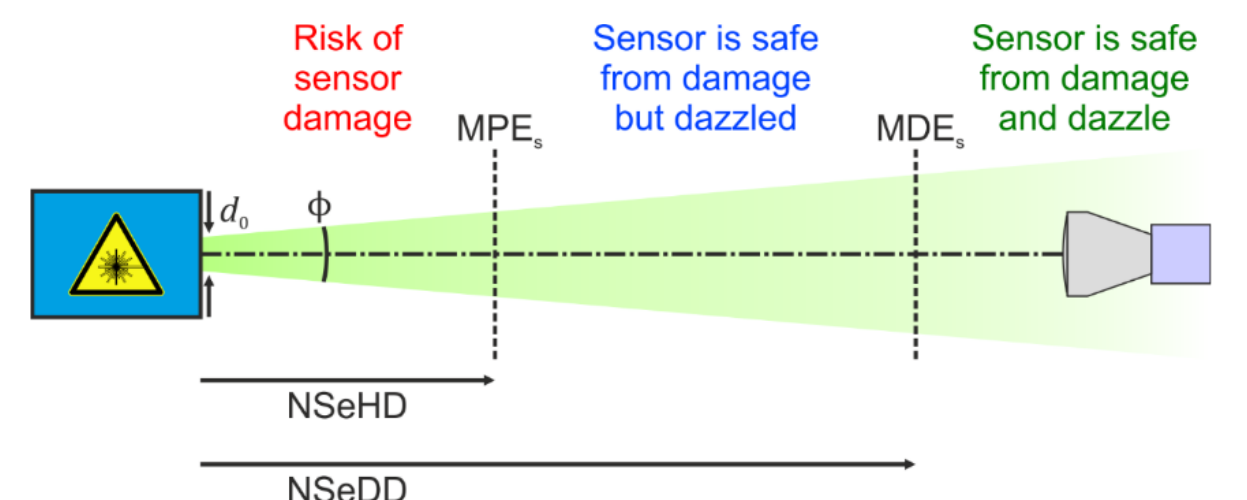
Figure 1. Exposure limits for sensors (maximum permissible exposure for a sensor, MPE S , and maximum dazzle exposure for a sensor, MDE S ) and corresponding hazard distances (nominal sensor hazard distance, NSeHD, and nominal sensor dazzle distance, NSeDD). Taken from reference [14].